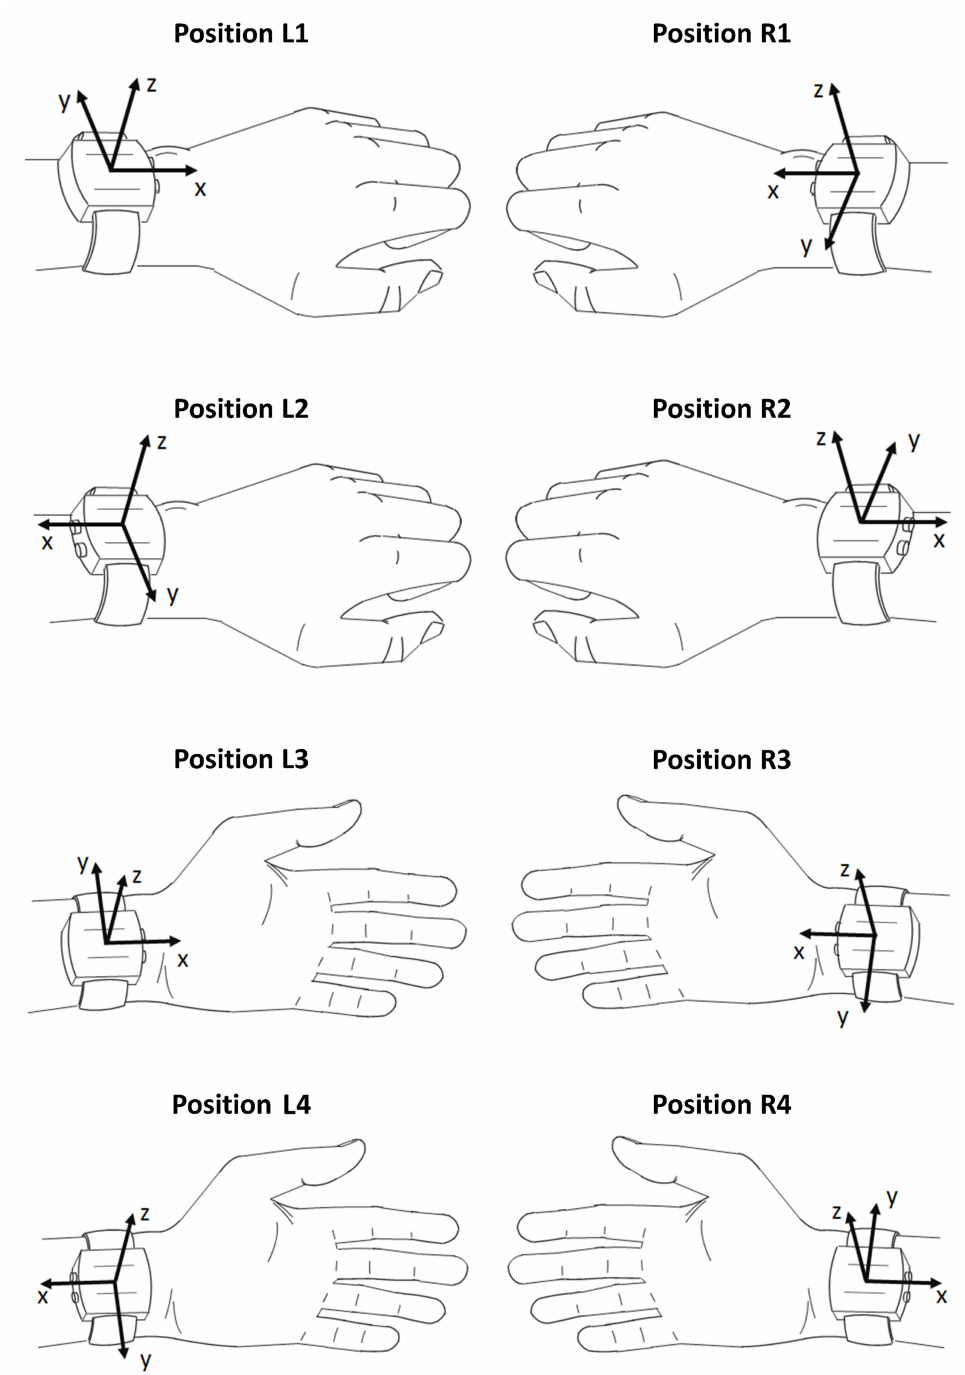
Figure 1. Eight positions of the wrist-worn wearable accelerometer displayed with the coordinate system on the